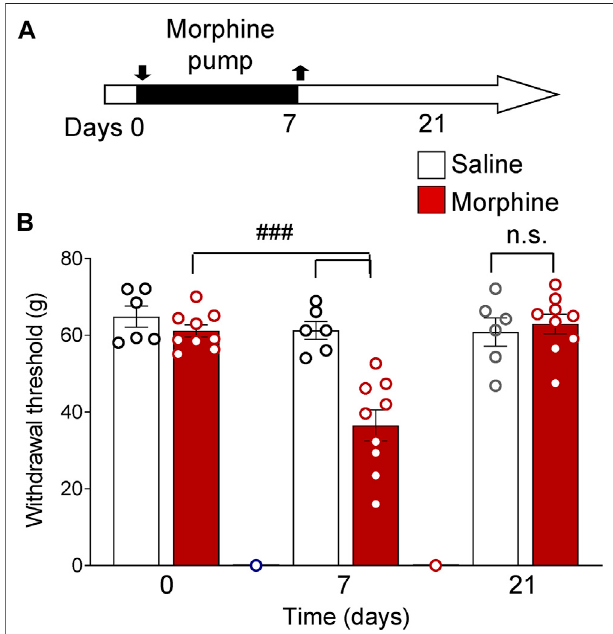
FIGURE 1 | Functional priming pain model. Increased mechanosensitivity induced by morphine treatment (priming). (A) Timeline of experimental procedures. Rats were treated with morphine or saline for 7 days. (B) Morphine-treated rats showed decreased paw withdrawal thresholds compared to morphine-treated baseline measures and compared tosalinegrouponday7( ### p < 0.001,two-wayANOVAwithTukey ’ sposthoc test, n = 15). By day 21 mechanosensitivity recovered to baseline levels (n.s., p > 0.05, two-way ANOVA withTukey ’ sposthoc test, n =15). Barhistograms show means ± SEM. Symbols represent values of individual